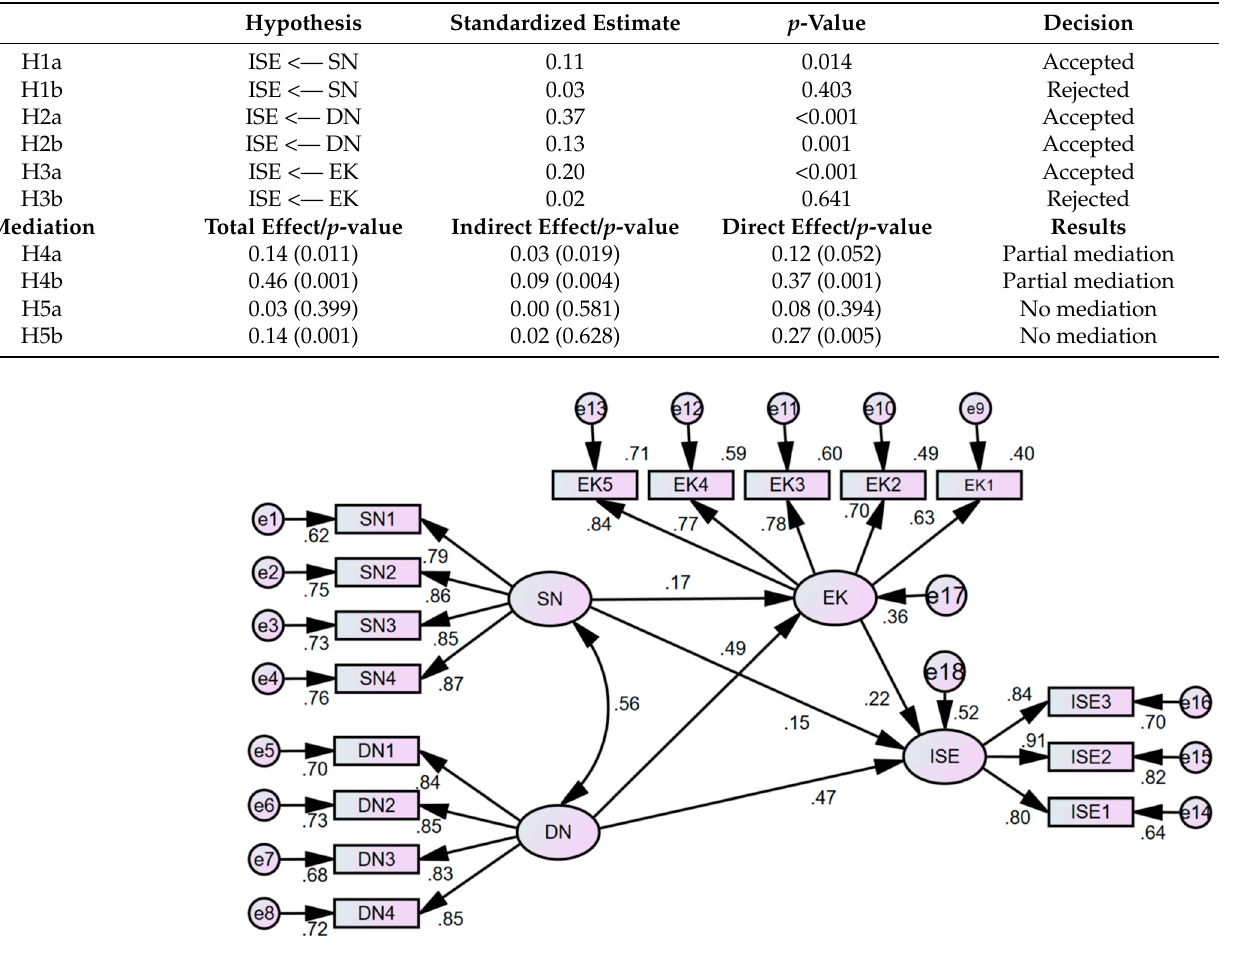
Figure 5. Mediation analysis for PH.